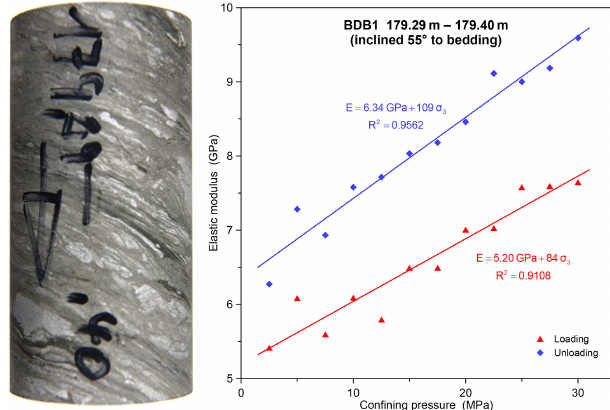
to 197.40m) and dependency of elastic modulus on confining pressure.